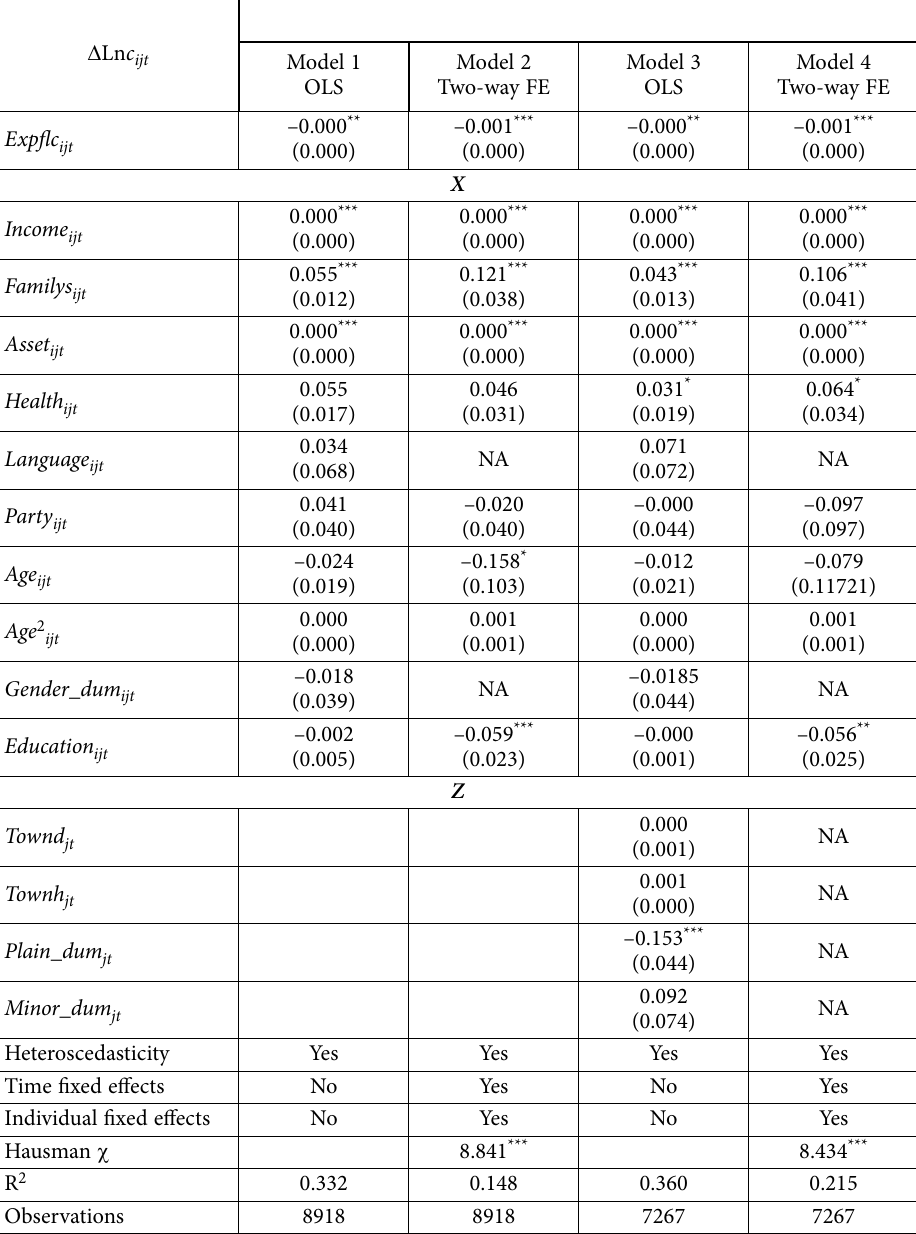
Table 4. Baseline estimate